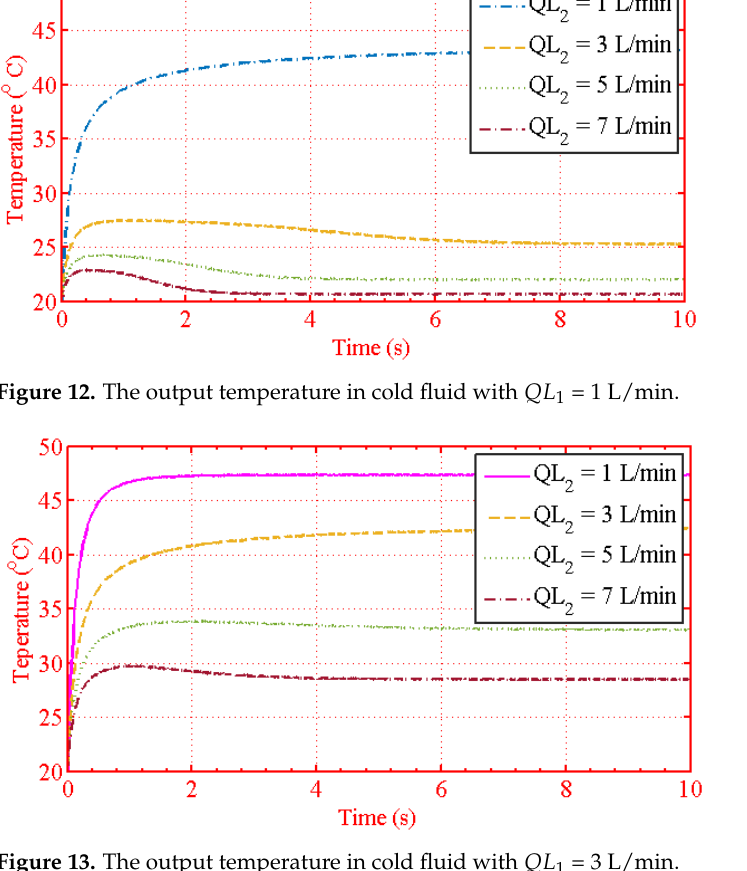
Figure 13. The output temperature in cold fluid with QL 1 = 3 L/min.